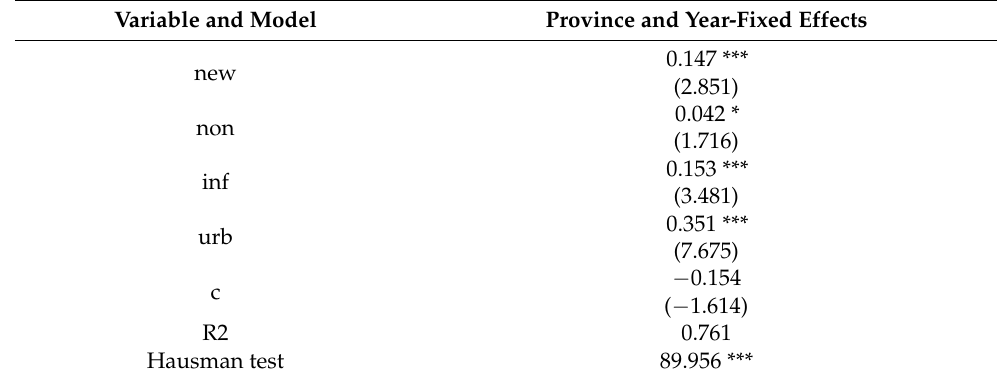
Table 4. Results of the effect of renewable energy consumption on sustainable